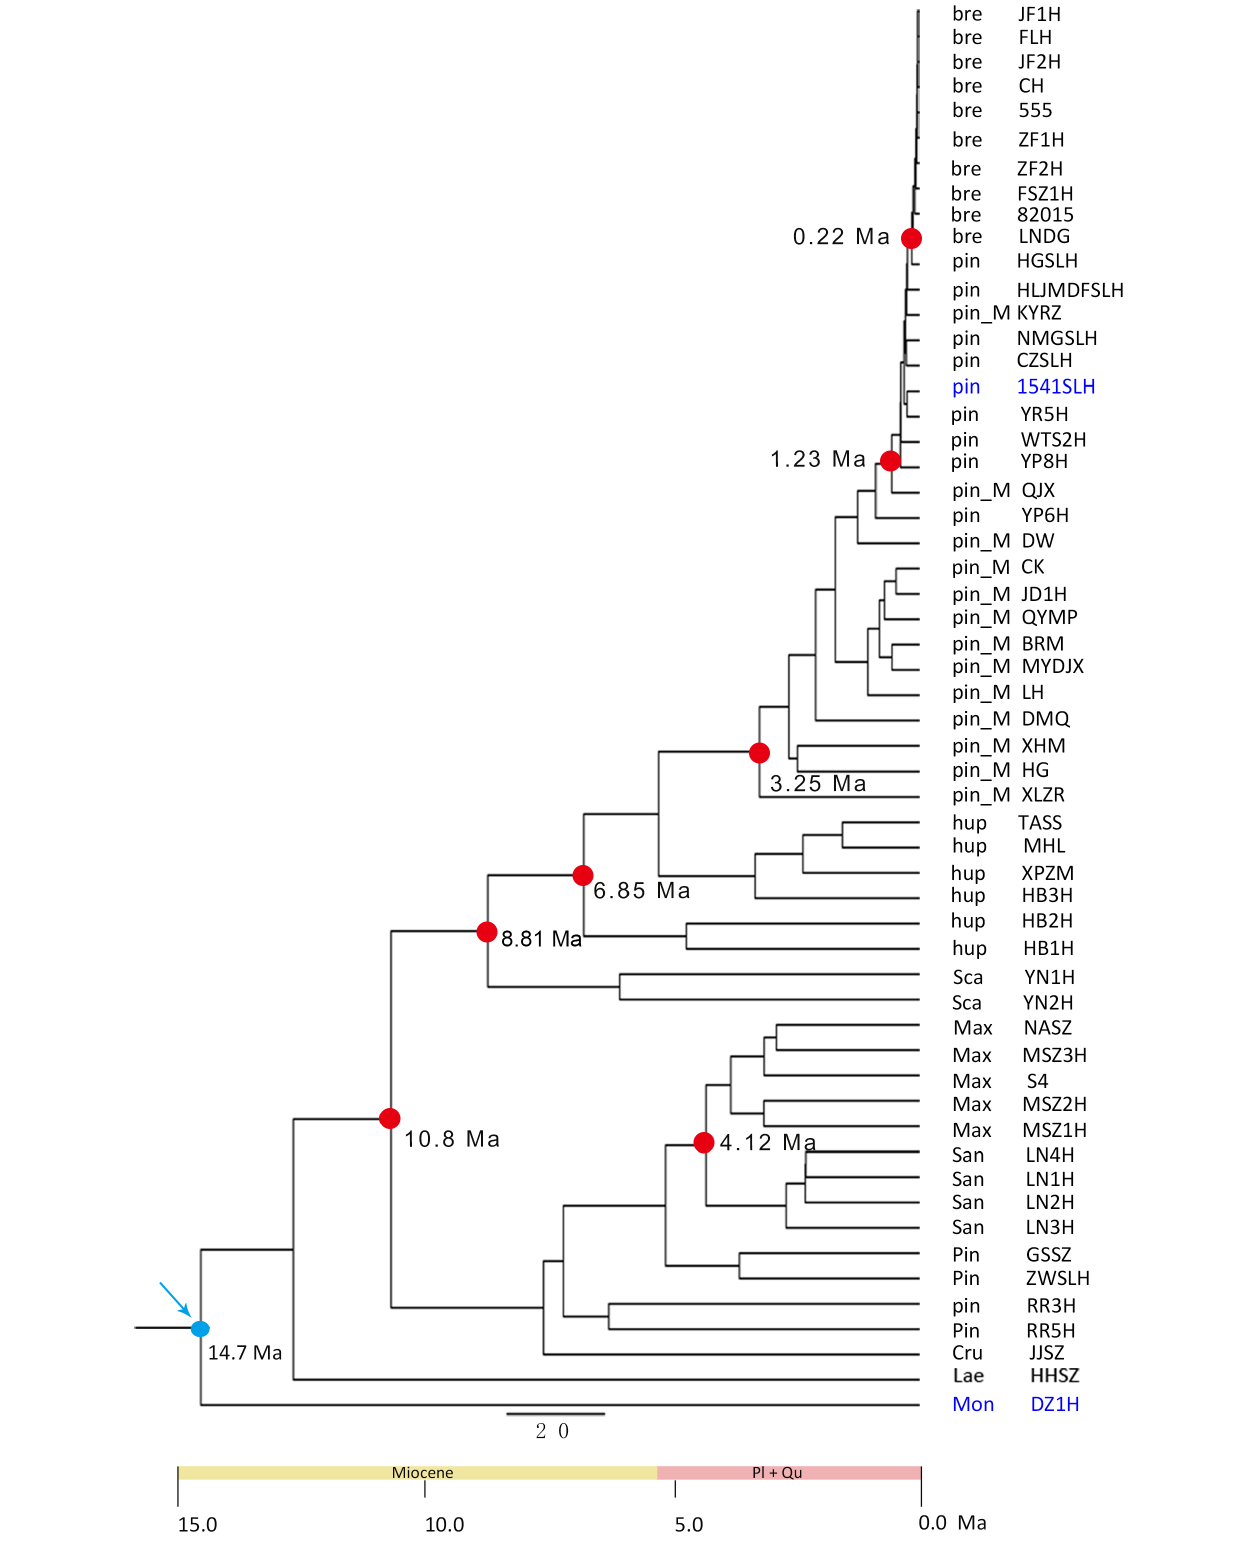
Frontiers in Plant Science |